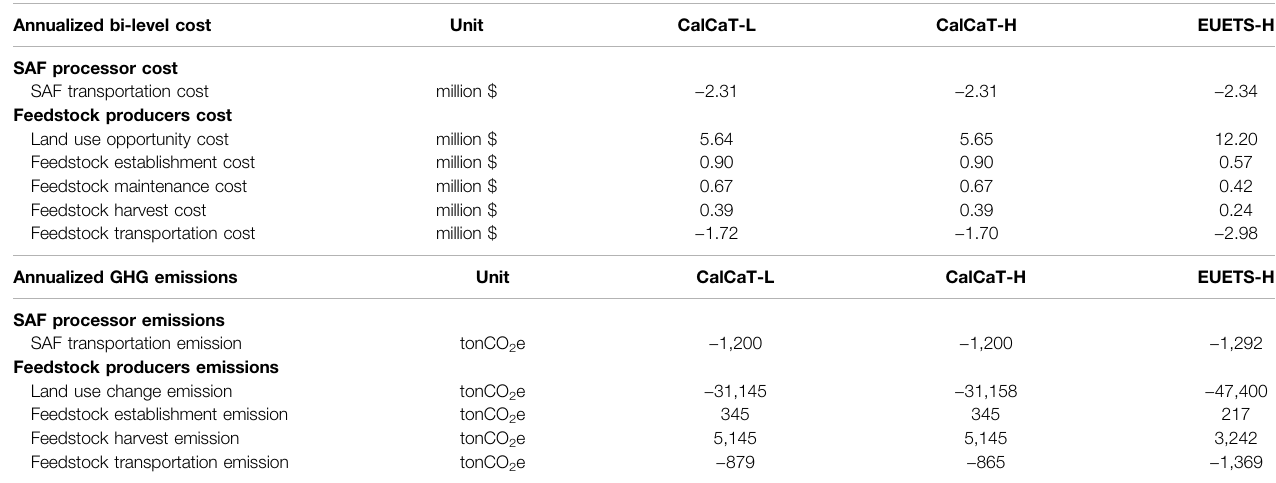
TABLE 5 | Changes in annualized variables for carbon credit scenarios compared to the